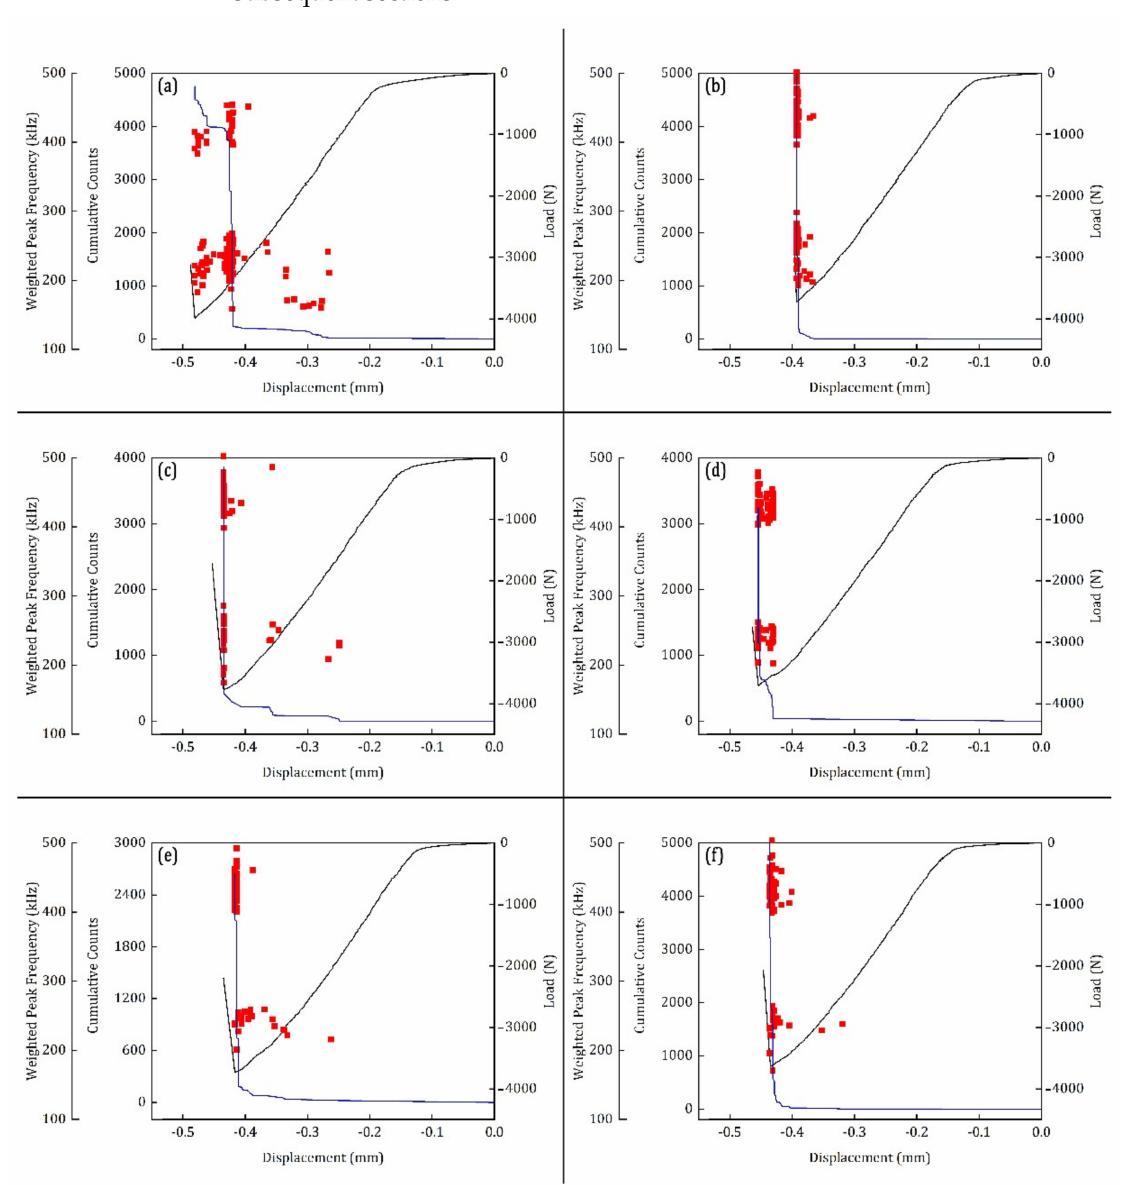
Figure 8. AE descriptors cumulative counts (blue lines) and W.P-Freq (red markers) plotted over the load–displacement curves of the SBS test performed at 100 ◦ C for the CFRP specimens ( a ) SBS_120–1, ( b ) SBS_120–2, ( c ) SBS_120–3, ( d ) SBS_120–4, ( e ) SBS_120–5 and ( f )